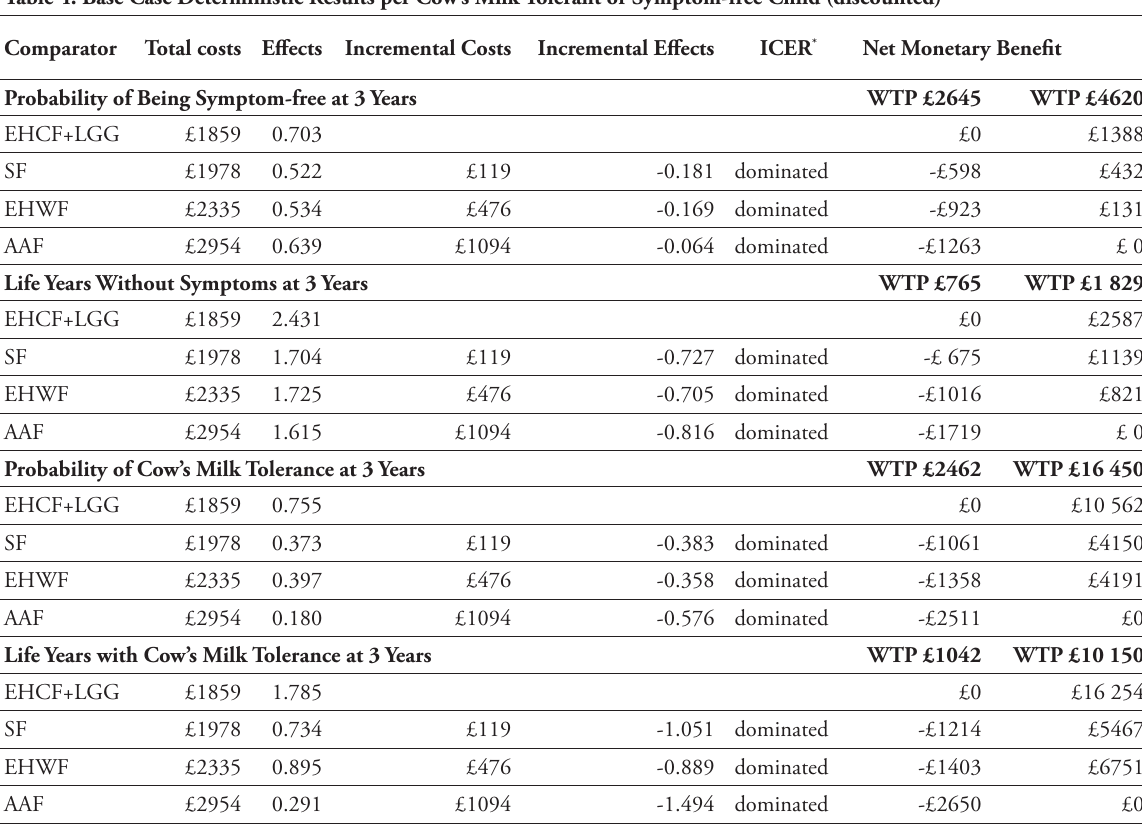
Table 4. Base Case Deterministic Results per Cow’s Milk Tolerant or Symptom-free Child (discounted)